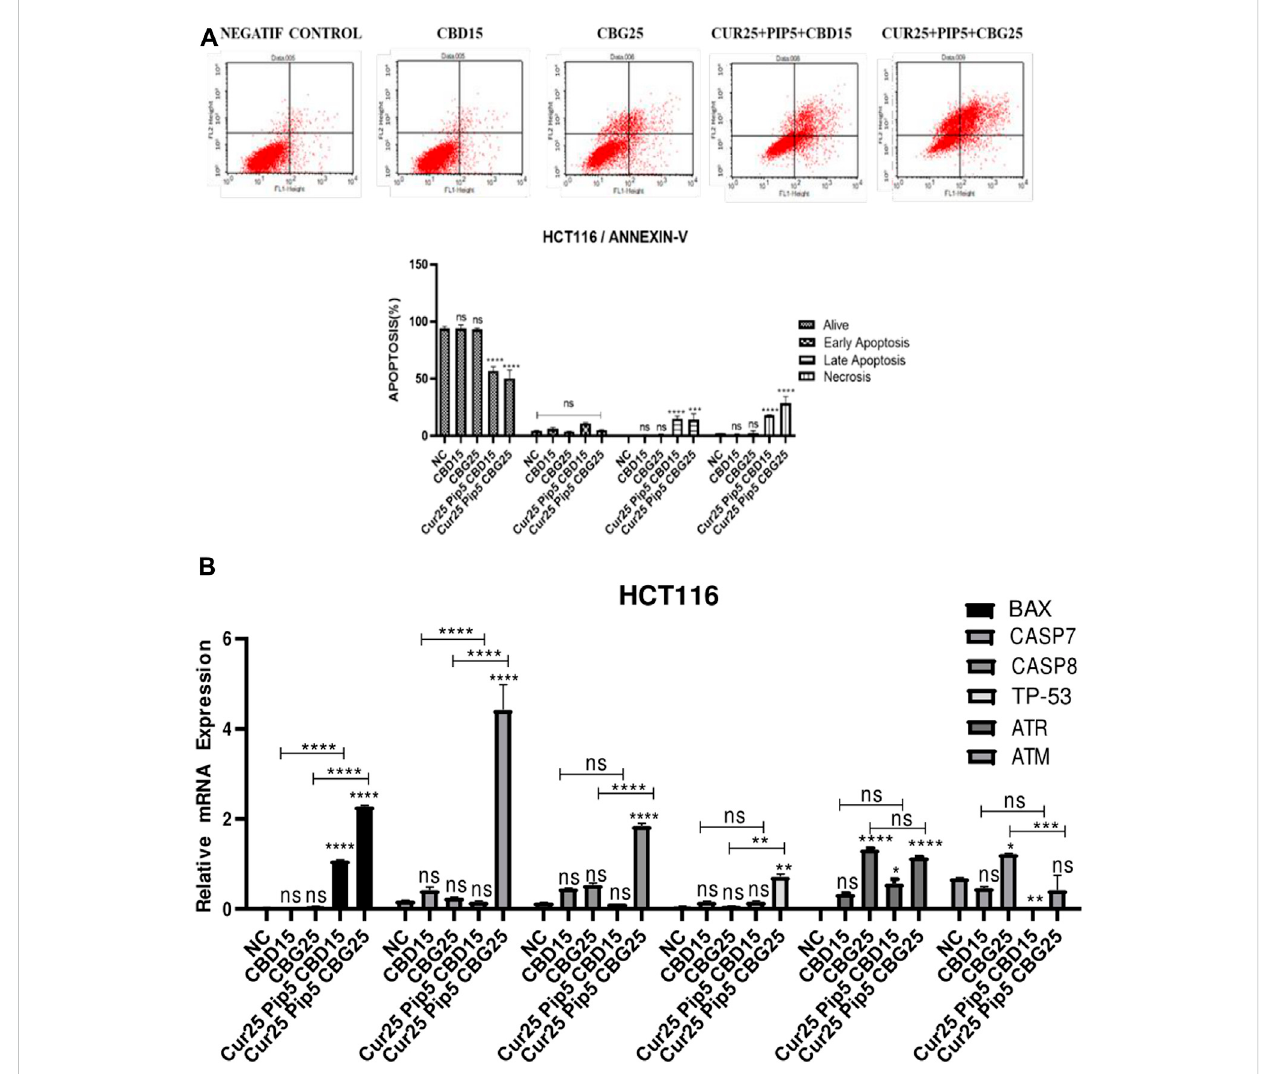
FIGURE 3 (A) Representative Annexin V-FITC/PI staining results for HCT116 cancer cells at 72 h quantitative analysis and their values are mean ± SD of three independent experiments (B) Representative graphapoptoticgenesexpressionpro fi lesofHCT116cells after 72 h.(ns:non-signi fi cant, *: p < 0.05, **: p < 0.01, ***: p < 0.001, ****: p <